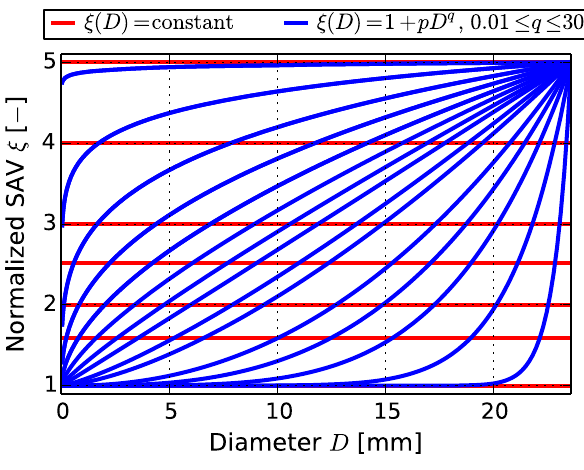
Figure 4. Synthetically generated ξ(D) relationships for deriv- ing normalized snowflake surface-area-to-volume ratio ξ from snowflake diameter D by Eq. (7) with D ≤ D max = 23 . 6mm. Shown ξ(D) curves reflect the total range of ξ(D) relationships used for modeling snowfall triple-frequency radar signatures in Sect. 4.2. Fig. 3. To estimate ξ(D) relationships at Alta and at